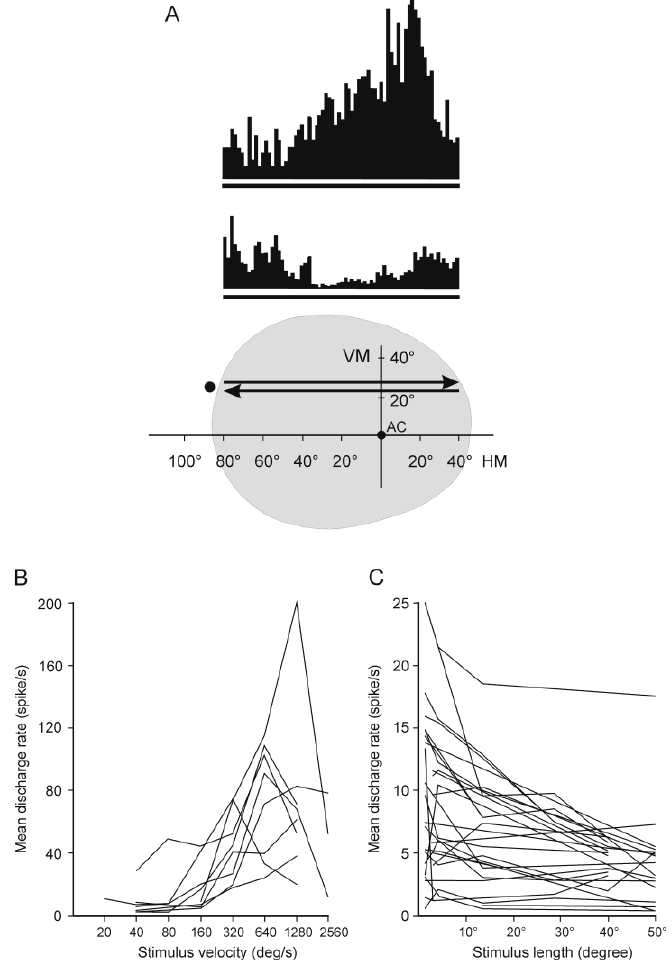
Figure 4. Visual properties of neurons in the ascending tectofugal system. A: Top: Peristimulus time histograms (PSTHs) of a directionally selective LM-Sg visual neuron in the ascending tectofugal system. Bottom: the position and movement of the stimulus in the visual field of the cat. The black spot left to the arrows symbolizes the moving visual stimulus. The upper and lower PSTHs correspond to the response of the neuron to the stimulus moving along the trace indicated by the upper and lower arrows, respectively. The grey part represents the extent of the visual receptive field. Abbreviations: AC: area centralis, HM: horizontal meridian, VM: vertical meridian. B: Velocity response curves for a spot stimulus (2° in diameter) of eight visual AEV neurons of this system. Note the high responsiveness of the units to high velocities! C: Effect of the length of the light stimulus (1° in width) on the response of visual neurons in the AEV. Note the maximal responsiveness of the neurons to small